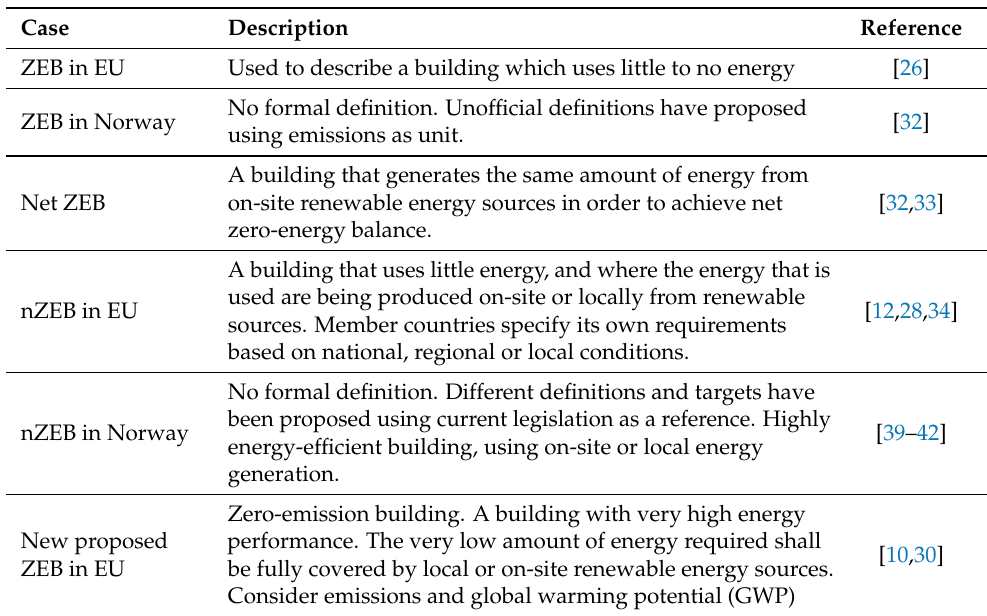
Table 1. Summary of ZEB